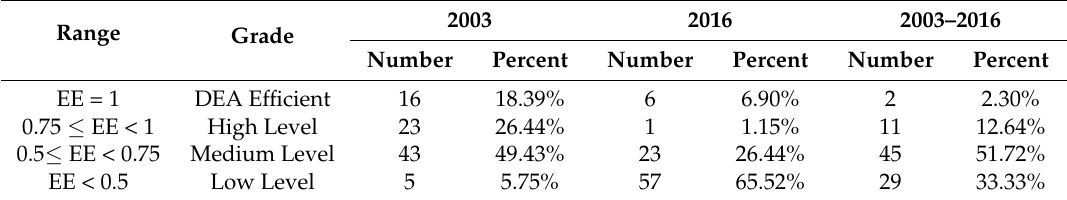
Table 4. Classification of SOFEs’ eco-efficiency